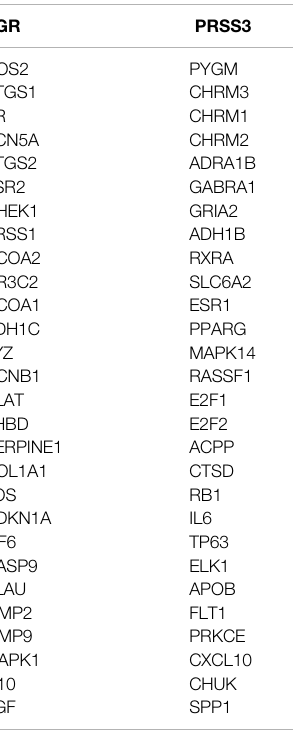
TABLE 1 | Gene list of